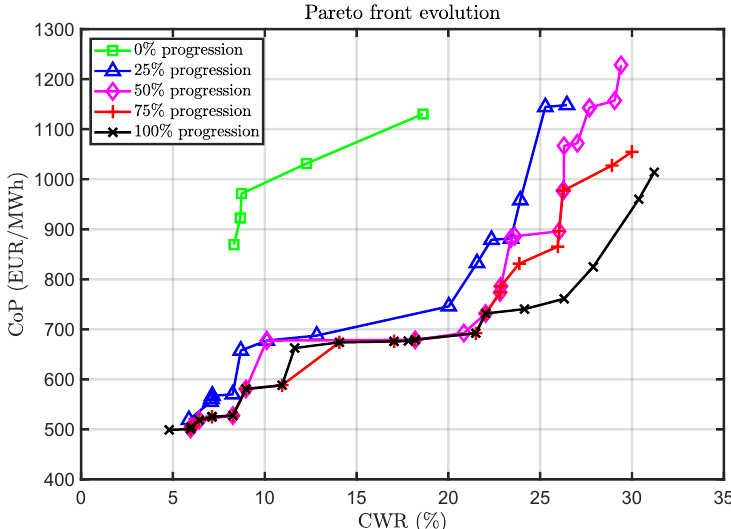
Figure 13. Evolution of the Pareto front, from 0% to 100%